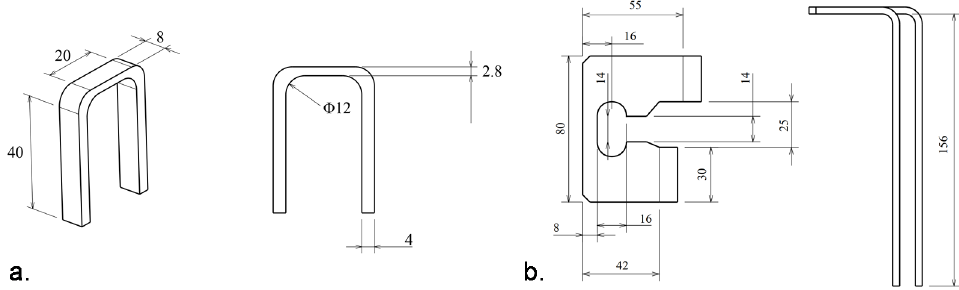
Figure 4. ( a ) Linear rectangular cross-section coil; ( b ) O-shape rectangular cross-section coil, units in mm [53].